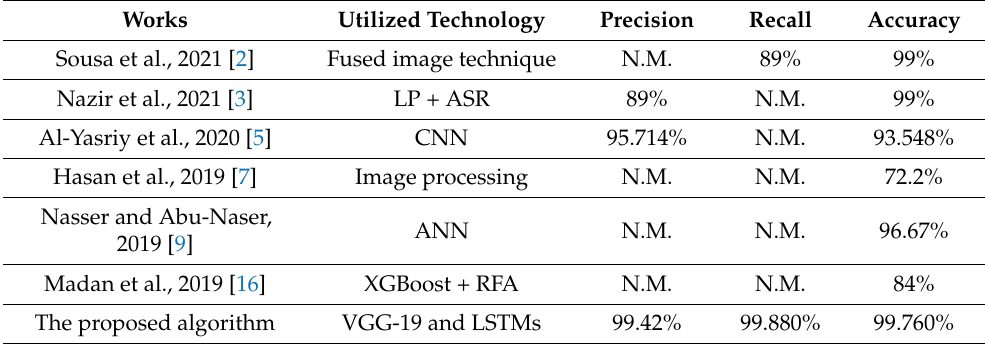
Table 7. Performance metrics and their values.